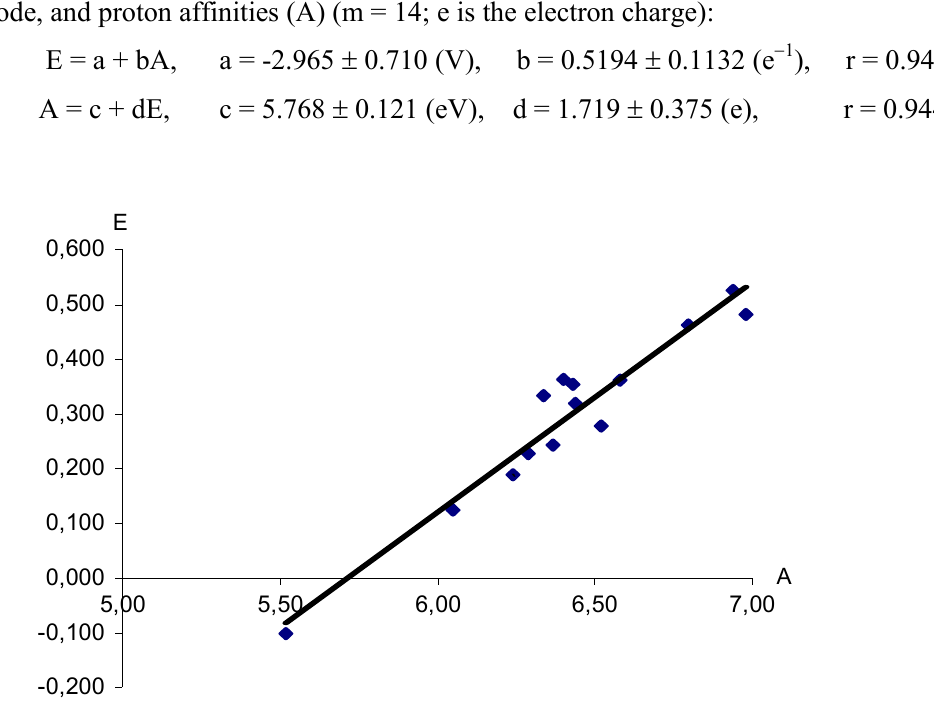
Figure 1. Dependence of half-wave potentials (E, V) of polarographic reduction of aryldiazonium XC H N + ≡ N cations (measured in nitromethane vs saturated Hg 6 4 affinities (A, eV). X = H, 3-CH Cl, 4-Cl, 3-Br, 4-Br. Correlation coefficient r =